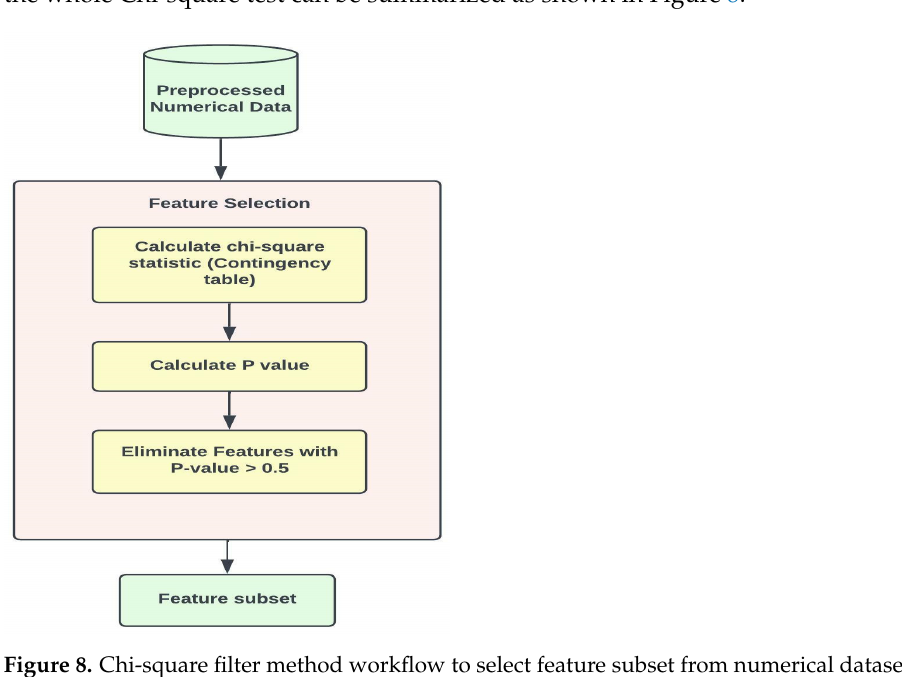
Figure 8. Chi-square filter method workflow to select feature subset from numerical Figure 8. Chi ‐ square filter method workflow to select feature subset from numerical dataset.